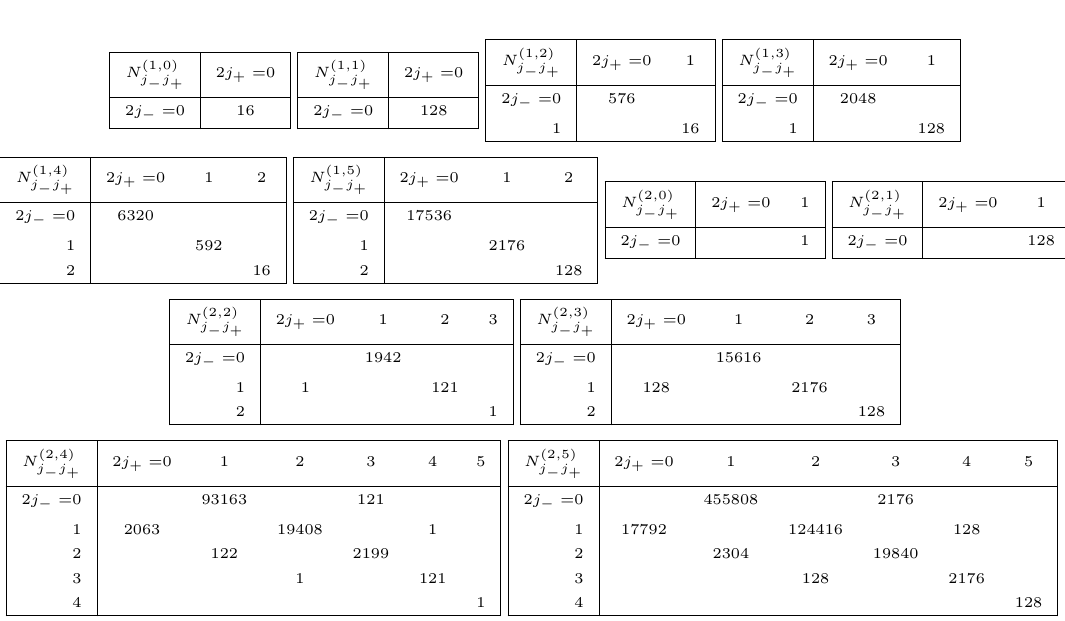
of M 2 , for base degree b (cid:20) 2 and (cid:12)ber degree d (cid:20) 5. j (cid:0) ;j +